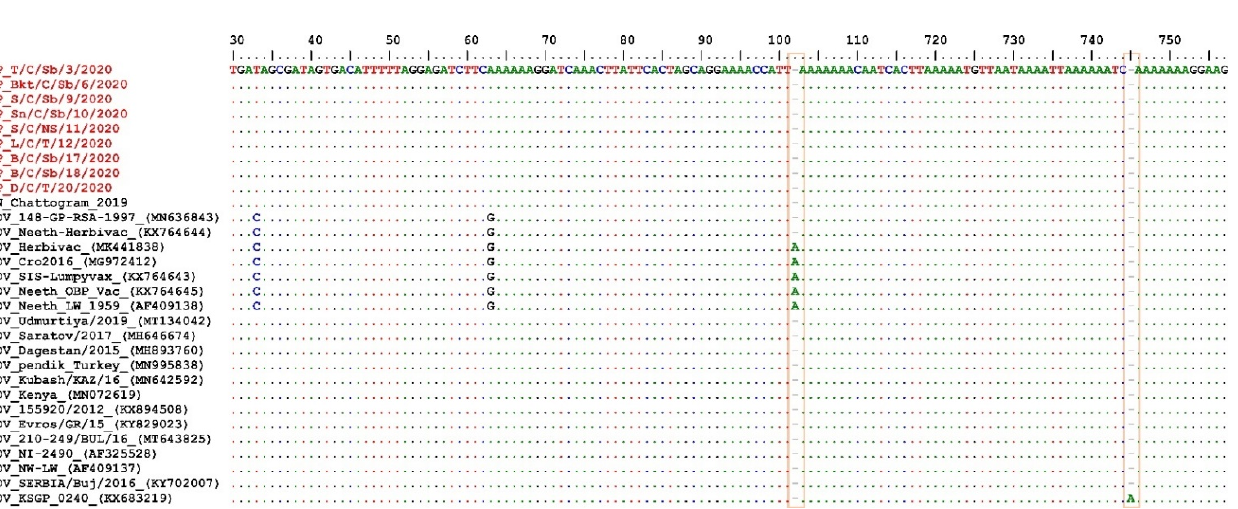
Figure 5. Multiple sequence alignments of the partial nucleotide sequences of the B22R gene. The Nepal isolates (in red) were aligned with representative LSDV sequences retrieved from GenBank. The nucleotide insertion in LSDV Neethling and LSDV KSGPO ‐ 240 vaccines that are absent in Nepal isolates are shown in the blocks. The dots indicate the identical nucleotides in the alignment.